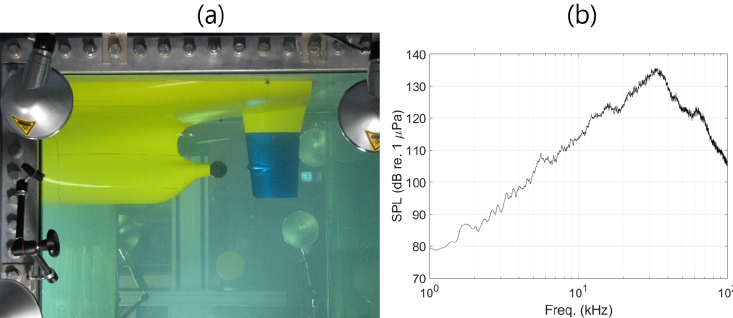
Figure 6. Configuration of the virtual source experiment ( a ) and measured sound pressure level ( b ), which is averaged for the 45-channel hydrophones. (SPL: sound pressure level, Freq.: frequency).